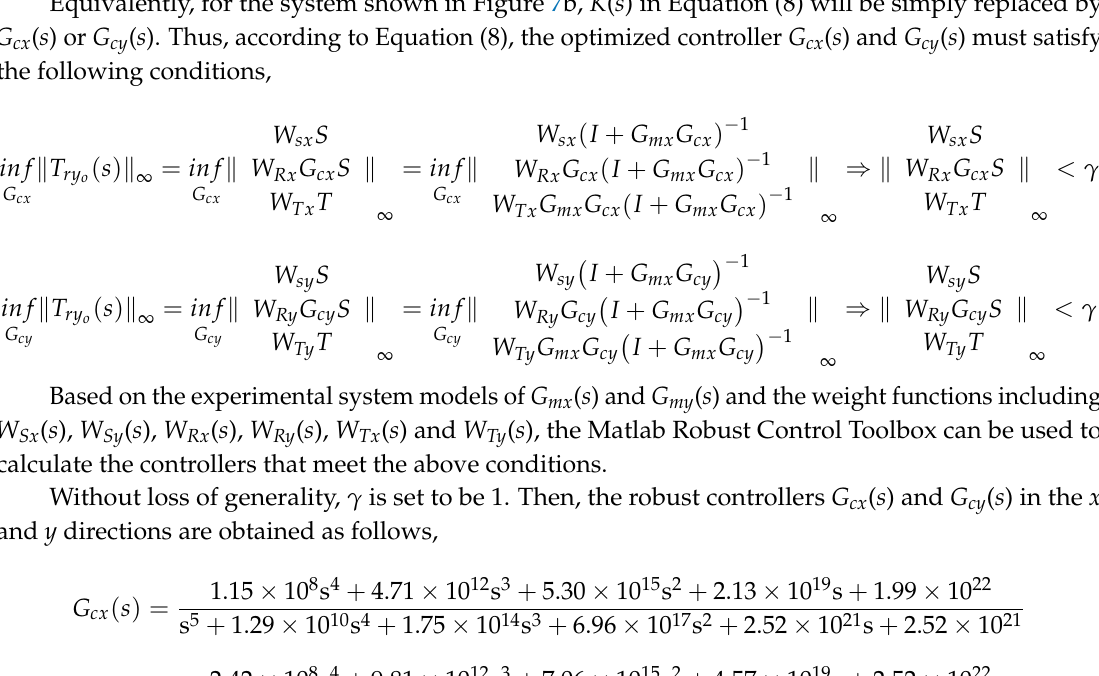
characteristics, and set the weight function 𝑊 𝑅𝑥 (𝑠) = 𝑊 𝑅𝑦 (𝑠) = 1 × 10 −4 to adjust the output of the controller to ensure that the PSD output changes at the millivolt level.